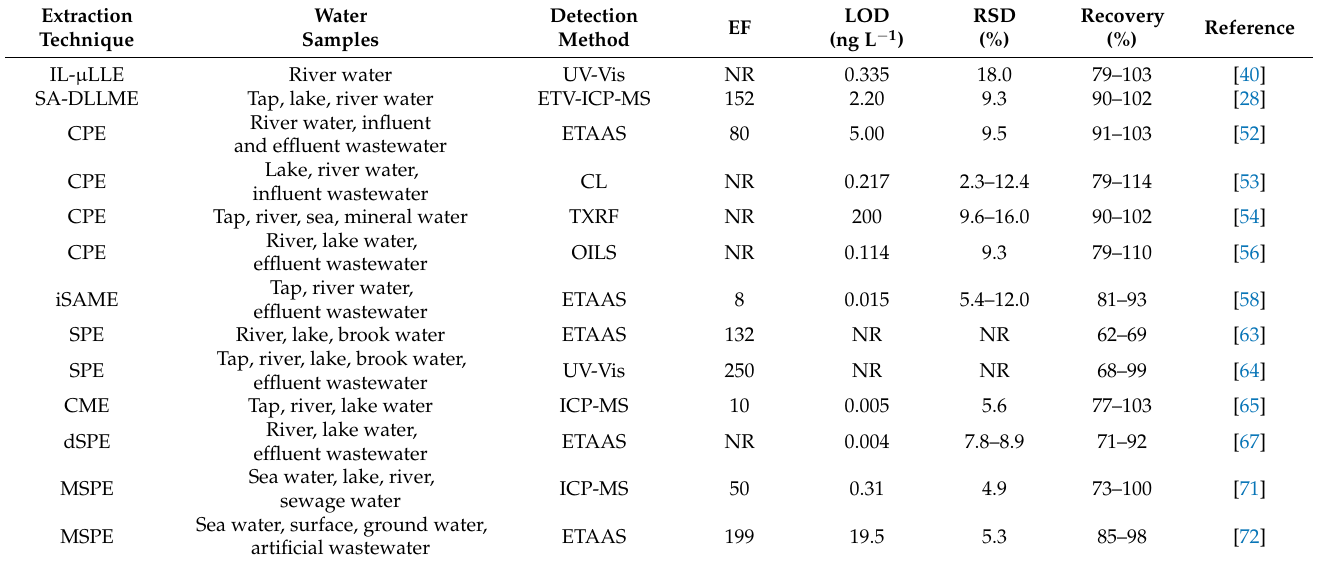
Table 1. Performance data obtained in the experiments on separation/preconcentration and quantifi- cation of AuNP in water samples by extraction and spectrometric